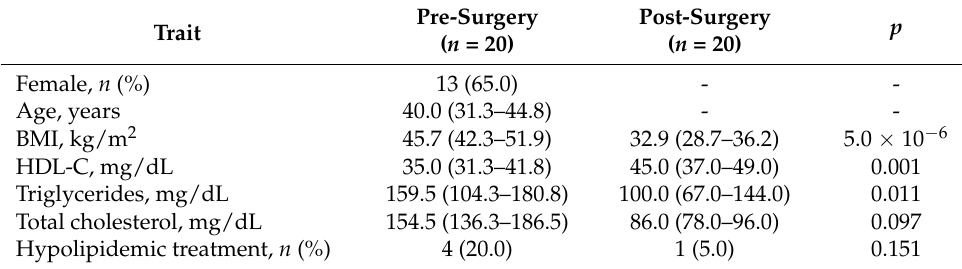
Table 2. Comparison of anthropometric and biochemical parameters before and after bariatric surgery. Trait